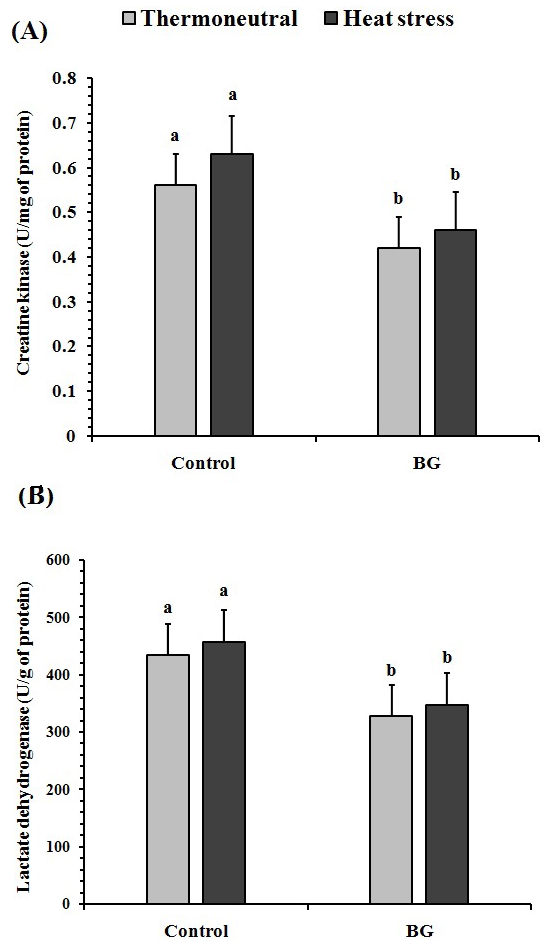
Figure 1. Effect of bee glue (BG) supplementation on (a) creatine kinase (expressed as Umg − 1 of protein) and (b) lactate dehydro- genase (expressed as Umg − 1 of protein) levels in chicken breast muscle. Mean values represent the average of six replicates of four groups ( n = 6). Values are means ± SEM. Within the graph, bars with different letters (a, b) are significantly different ( P < 0 .